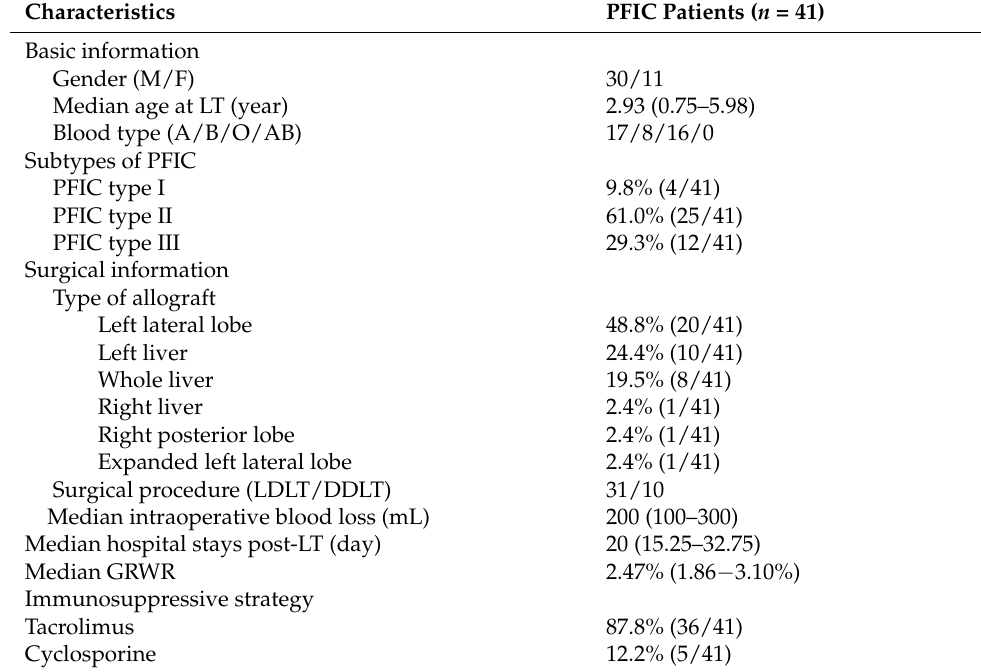
Table 1. Basic clinical characteristics of the PFIC